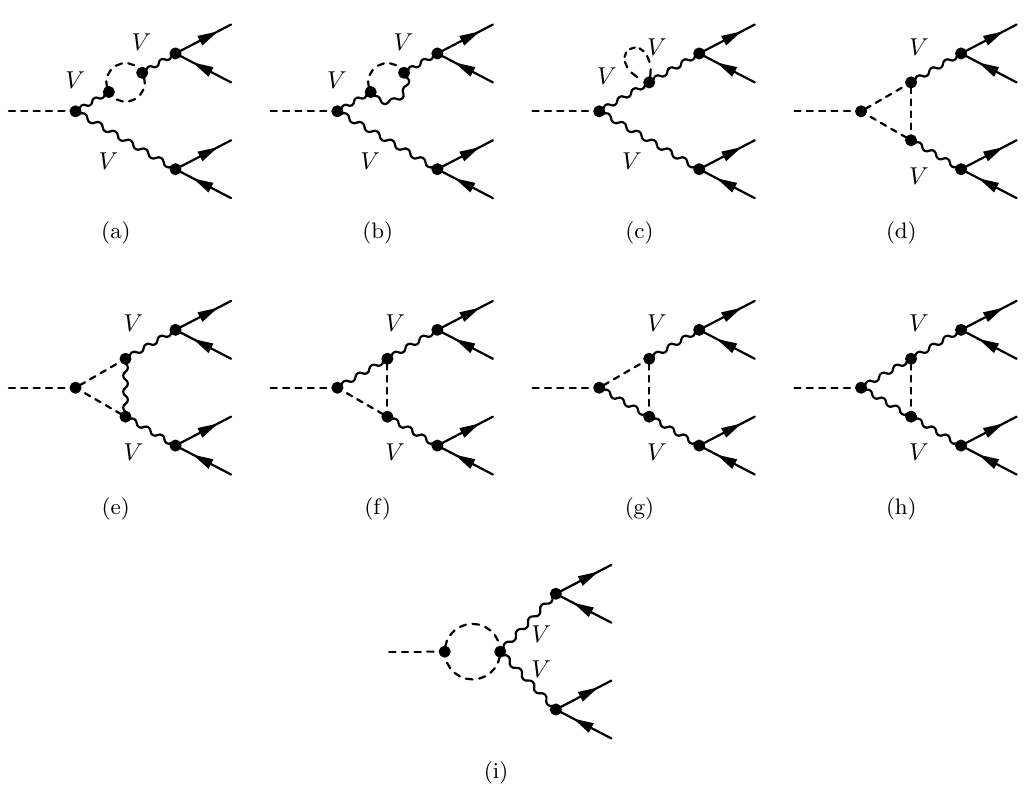
Figure 2 . Exemplary generic one-loop diagrams of the h V V vertex correction with additional Higgs bosons, i.e. the heavy neutral CP-even, the neutral CP-odd, and the charged Higgs bosons, H ; A 0 ; H (cid:6) , respectively. The internal dashed lines represent any light or heavy Higgs boson; the gauge boson V can be a W boson, a Z boson, or a photon depending on the charge (cid:13)ow and (cid:12)nal